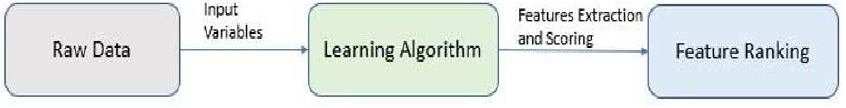
Figure 2. End-to-end feature engineering process.